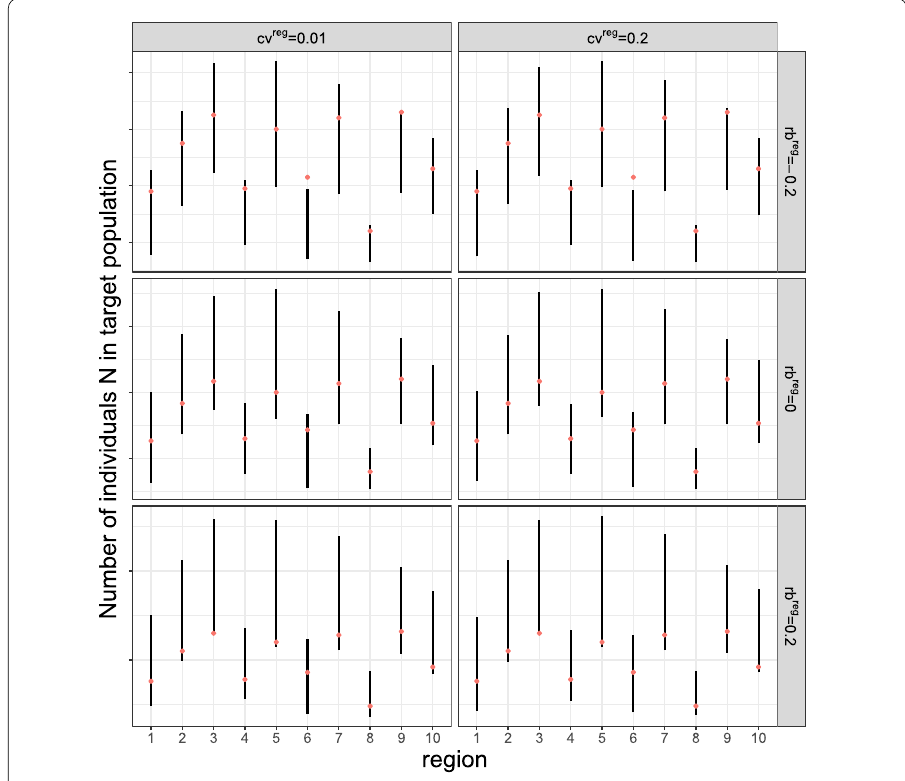
Figure 18 Credible intervals for the initial number of individuals N 0 per region. Credible intervals (prob = 95%) for the initial number of individuals N 0 per region compared to true values (in red) computed according to the whole module integration using the RSS geolocation model with uniform prior and the negative binomial inference model and different values of rb reg and cv reg